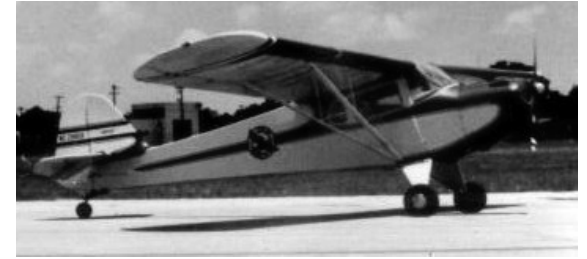
Fig 2. LM-2X-2P light airplane